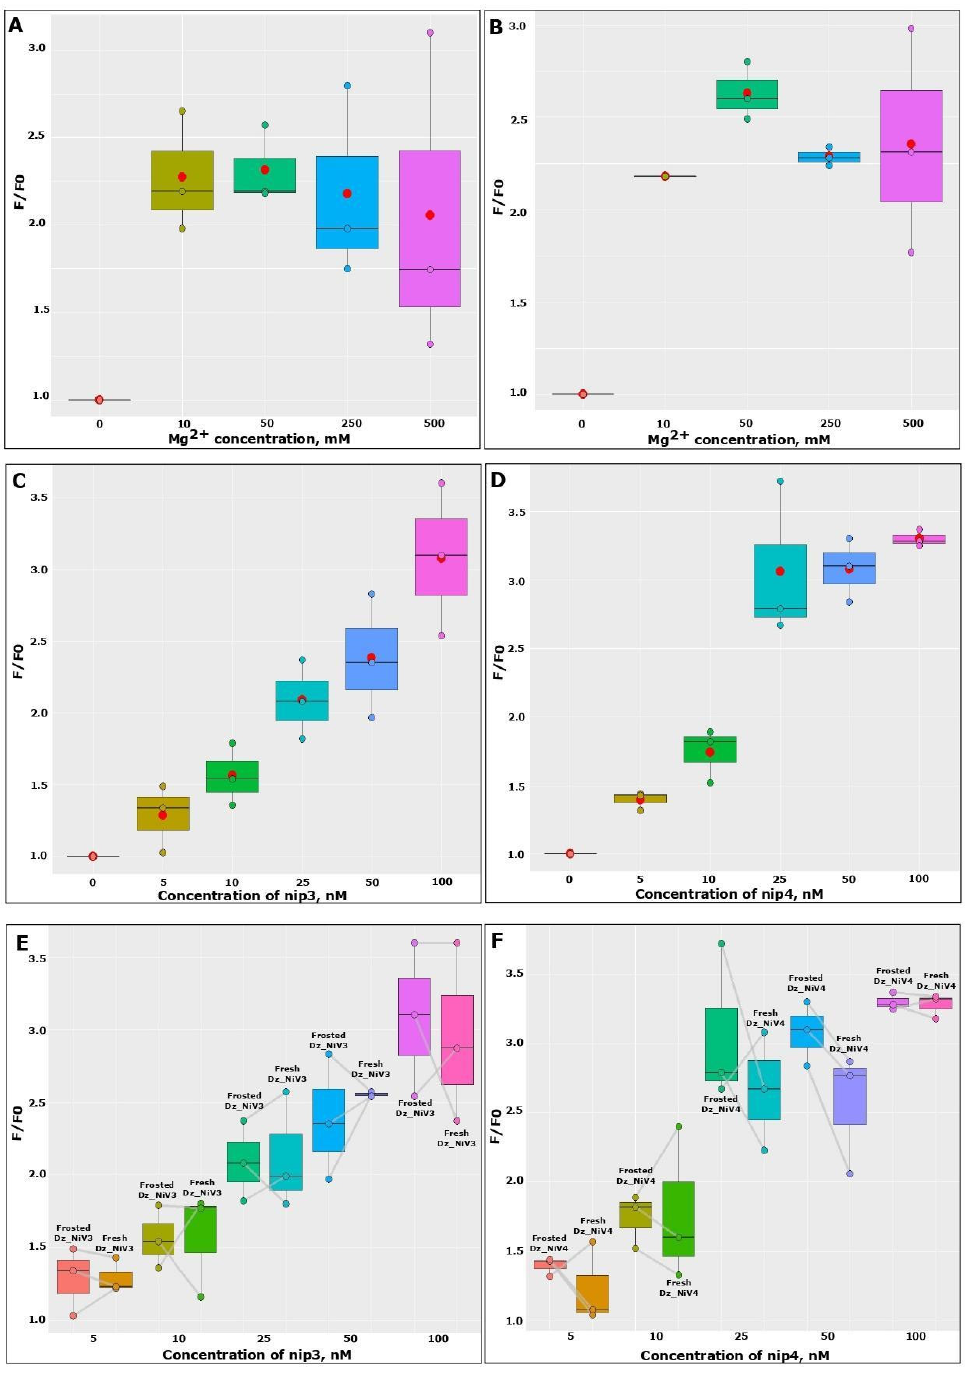
Figure 5. Fluorescence intensity under limiting factors, such as magnesium concentration, for Dz_NiV3 ( A ) and Dz_NiV4 ( B ); target RNA concentrations for Dz_NiV3 ( C ) and Dz_NiV4 ( D ); and triple freezing of Dz_NiV3 ( E ) and Dz_NiV4 ( F ) prior to detection. The red dots on the graphs indicate mean values.